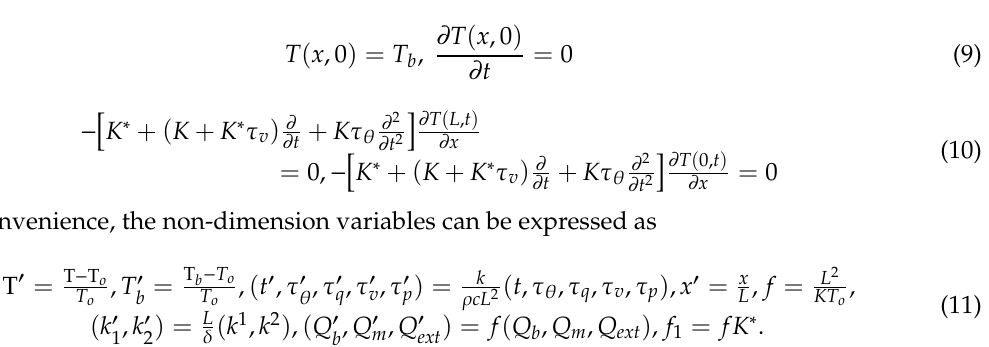
Figure 1. One-dimensional schematic geometry of skin.